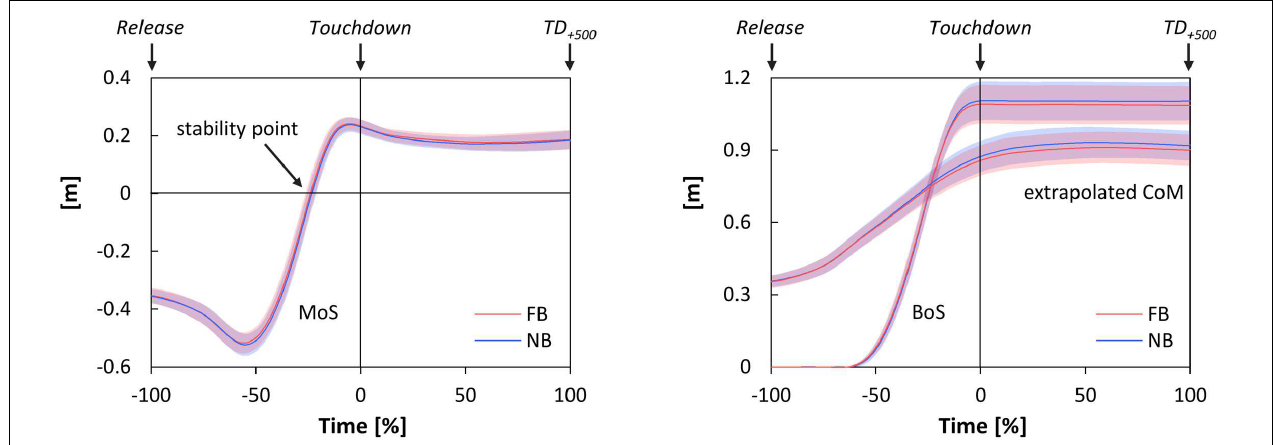
FIGURE 3 | Time-normalized data of the margin of stability (MoS, left), the extrapolated center of mass (extrapolated CoM), and the anterior boundary of the base of support (BoS, both right) during Falling phase and Stance phase as functions of oral motor tasks (FB, force-controlled biting; NB, non-biting). Falling phase : from Release until Touchdown (normalized from − 100 to 0%); Stance phase : from Touchdown until 500 ms after Touchdown ( TD + 500 ) (normalized from 0 to 100%); stability point: time point the MoS changes from negative to positive values. All data are presented as mean ± CI 95